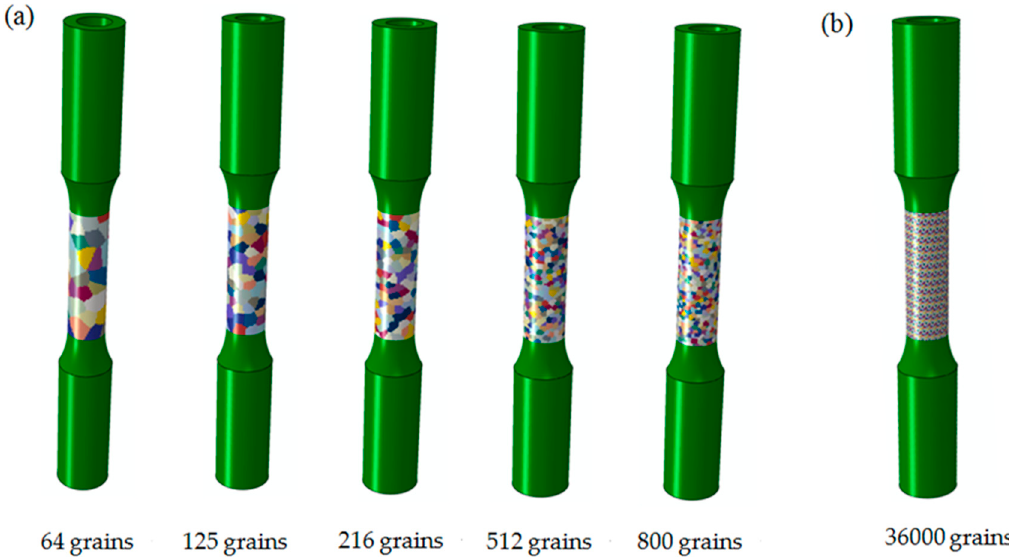
Figure 8. The center gauge region of the GFEM with di ff erent grain numbers: ( a ) containing 64, 125, Figure 8. The FEM (Finite Element Model) of thin-walled tube specimen with different grain 216, 512, and 800 grains for each grain composed of many elements; ( b ) containing 36,000 grains for numbers. each element representing one